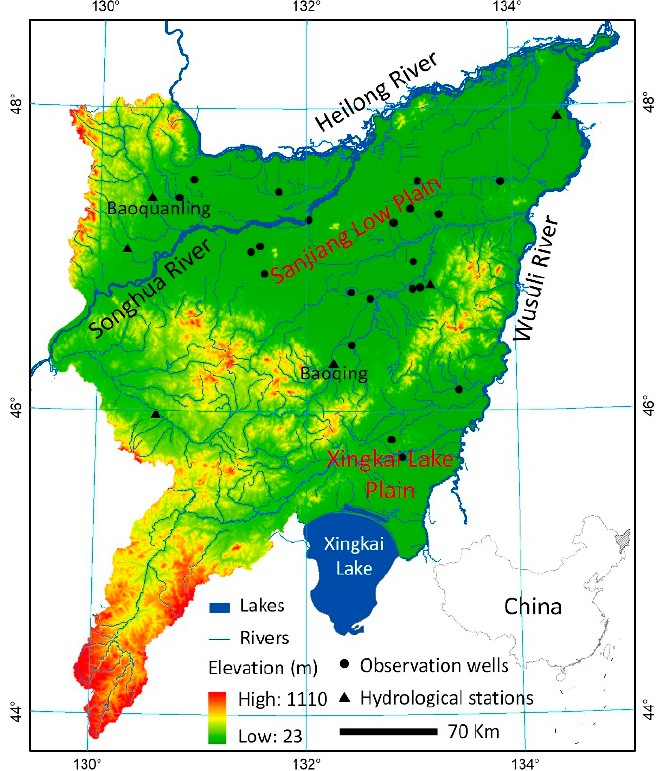
Figure 1. Location, geomorphology, river system, and other information regarding the Sanjiang Plain.